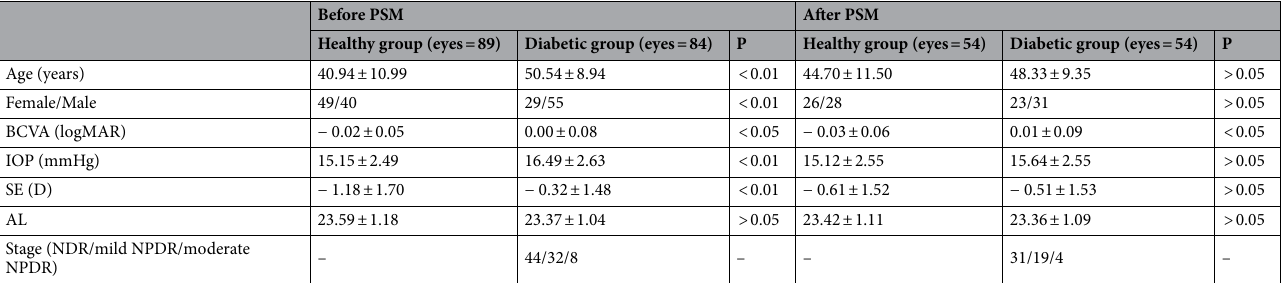
Table 1. Demographic and clinical characteristics of patients by group. BCVA best corrected visual acuity, IOP intraocular pressure, SE spherical equivalent, AL axial length.